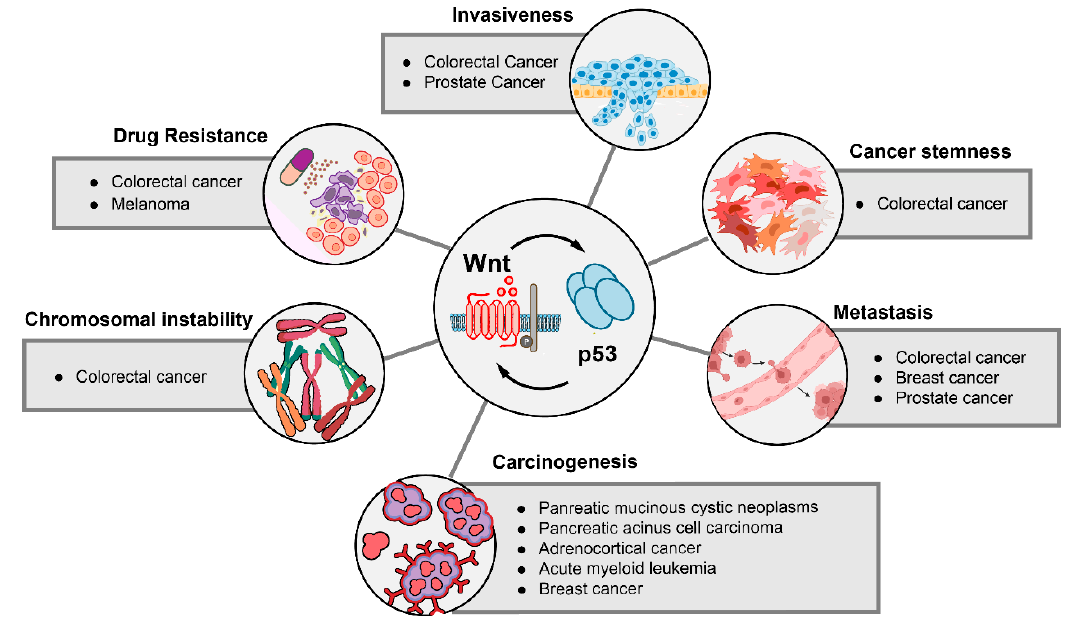
Figure 4. Cancer phenotypes that are regulated by the interaction of Wnt signaling and p53. Cancer phenotypes that depend on alterations of the Wnt and p53 pathways are shown. Tumor entities in which phenotypic effects of p53-Wnt cross-talk were detected are listed.